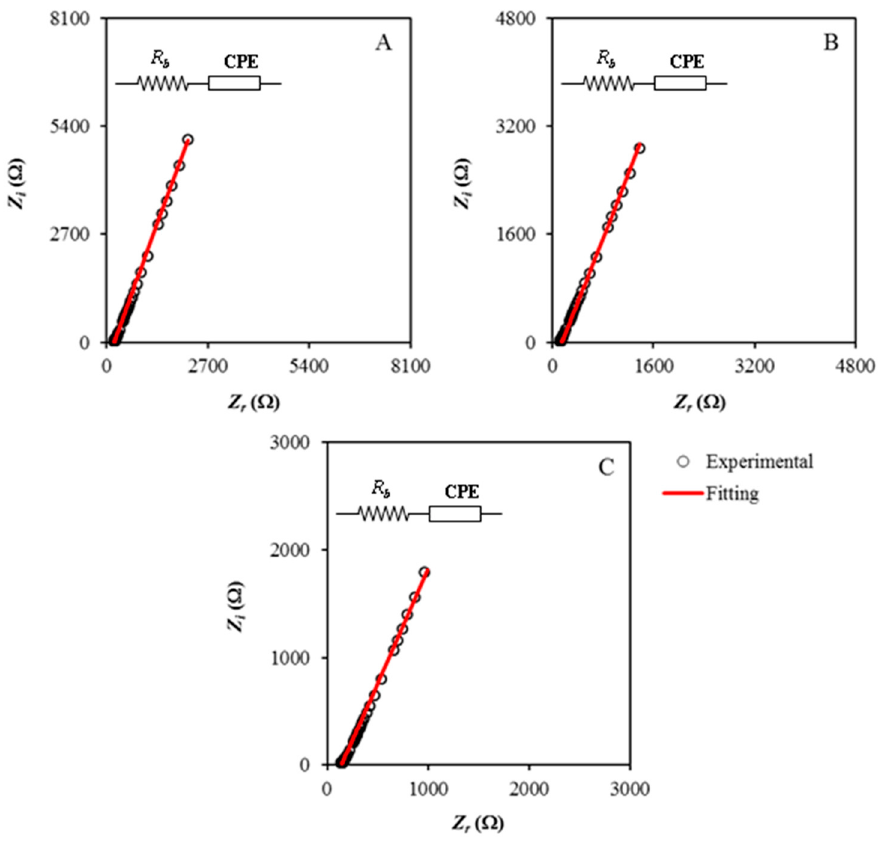
Figure 3 . Nyquist plots of the electrolytes of ( A ) CMNG1, ( B ) CMNG2 and ( C ) CMNG3, respectively, at room temperature. The inset figure is the suitable electrical equivalent circuit. Table 1 . Room temperature ionic conductivity and circuit elements for the plasticized polymer electrolytes (PPEs).